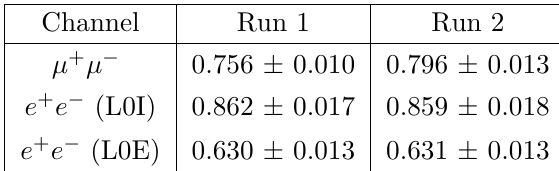
Table 2. E(cid:14)ciency ratios between the nonresonant and resonant modes, (cid:15) ( (cid:3) 0 pK (cid:0) J= ( ! ‘ + ‘ (cid:0) )), for the muon (cid:12)nal state and electron (cid:12)nal state in the two trigger categories and data-taking periods. The uncertainties are statistical